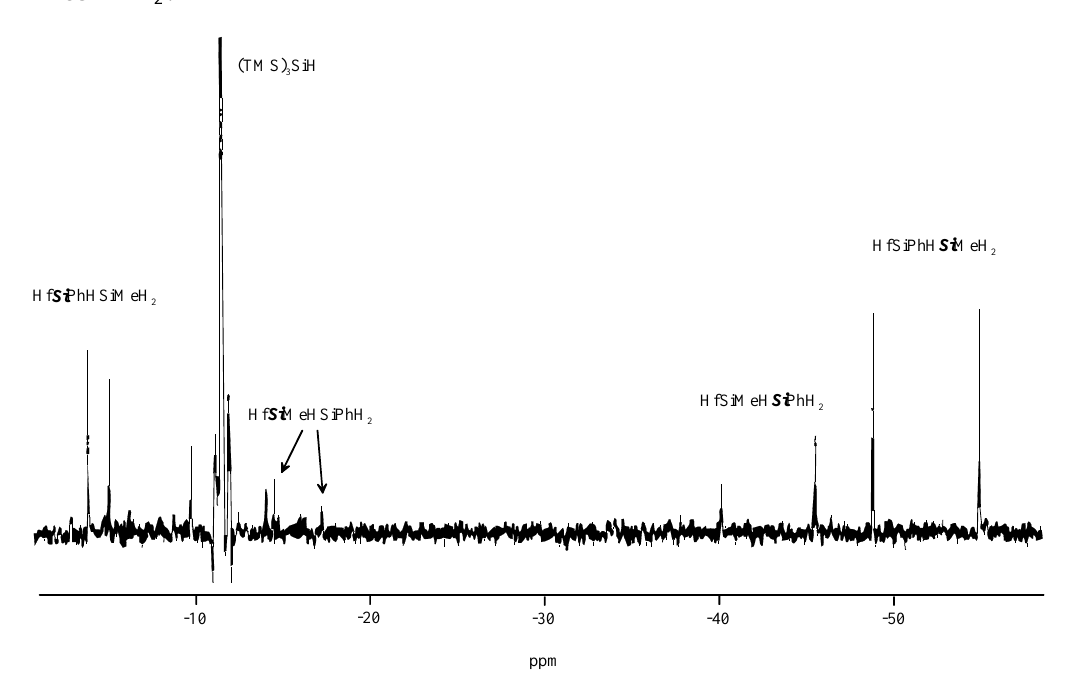
Figure 4. 29 Si{H} INEPT-NMR spectrum of CpCp*Hf(Cl)SiHPhSiMeH SiHMeSiPhH 2